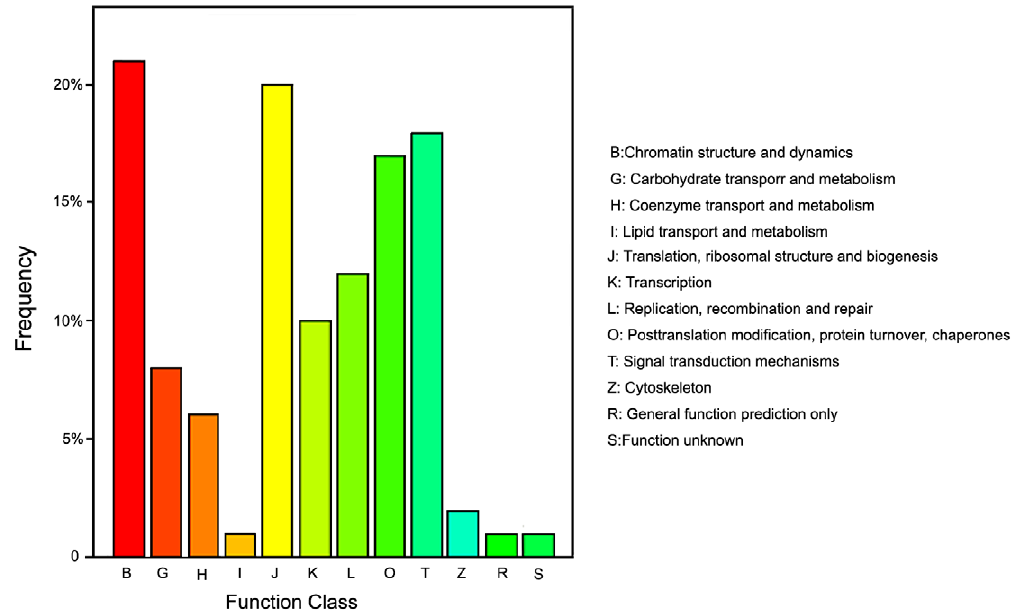
Figure 3. COG function classification of the predicted target genes.